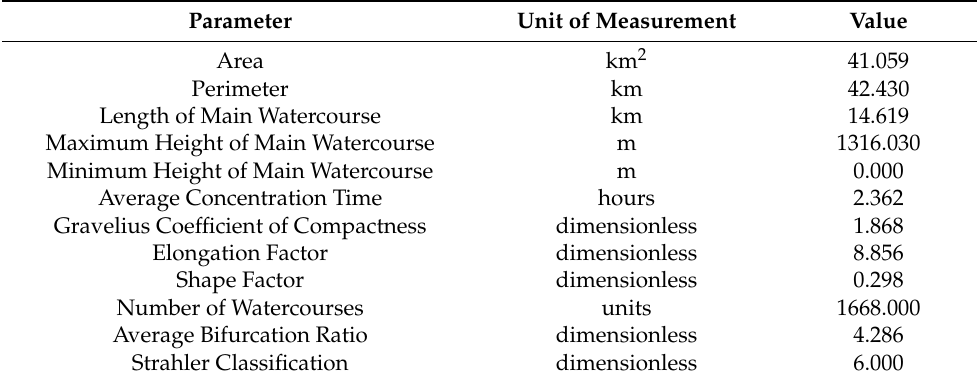
Table 1. Parameters calculated or extracted from